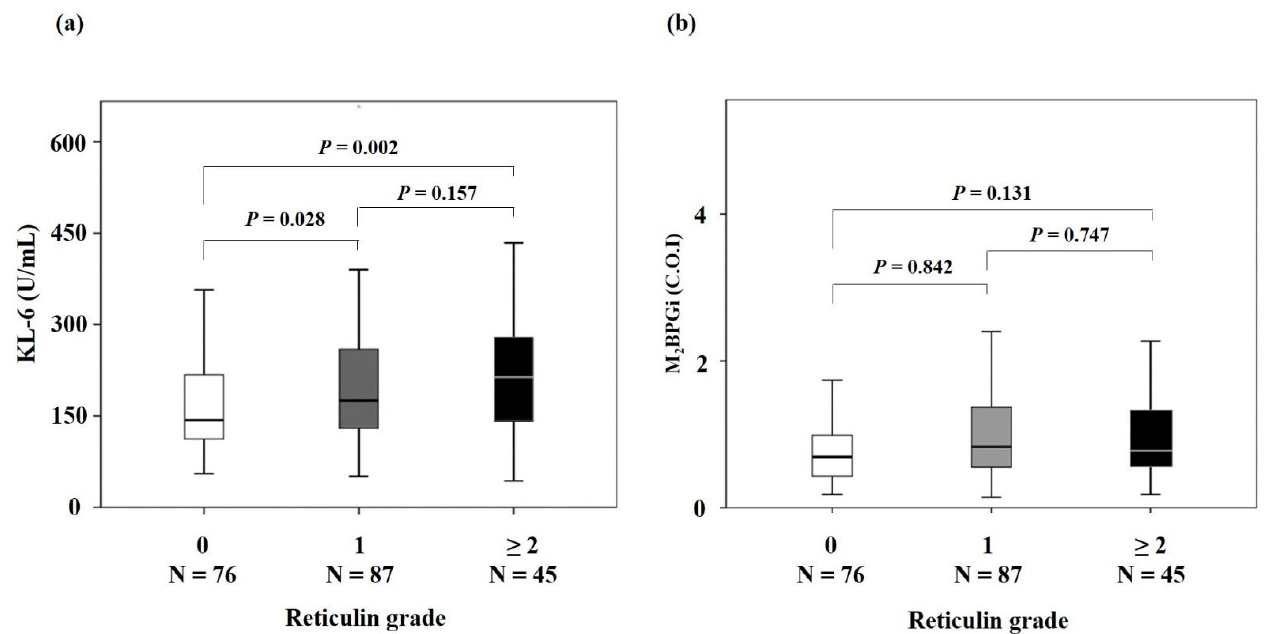
Figure 1. Box and whisker plots for KL-6 ( a ) and M 2 BPGi levels ( b ) at each reticulin grade. In each box plot, a box is drawn from the first quartile to the third quartile, a horizontal line goes through the box at the median, and the whiskers go from each quartile to the minimum or maximum. The KL-6 levels increased with the reticulin grade ( p = 0.010). There was a significant difference in KL-6 levels between reticulin grade 0 and 1 and between reticulin grade 0 and 2 ( p = 0.028 and 0.002, respectively; Kruskal-Wallis test with post-hoc analysis). The M 2 BPGi levels, however, did not show significant difference ( p = 0.060). Abbreviations: KL-6, krebs von den lungen-6; M 2 BPGi, mac-2 binding protein glycosylated isomer; C.O.I, cut-off index.